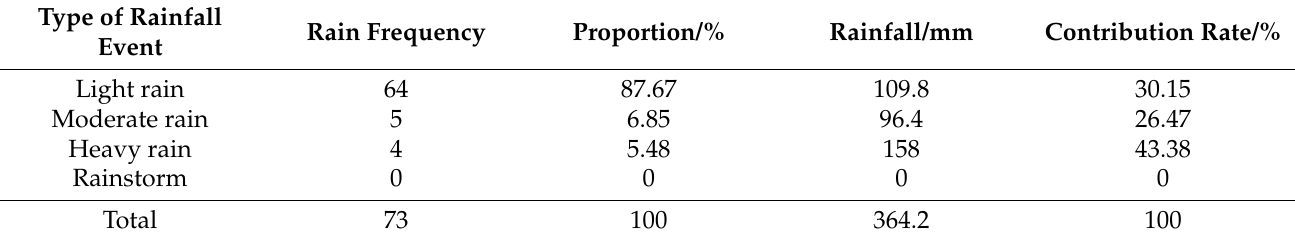
Table 5. Characteristics of rainfall